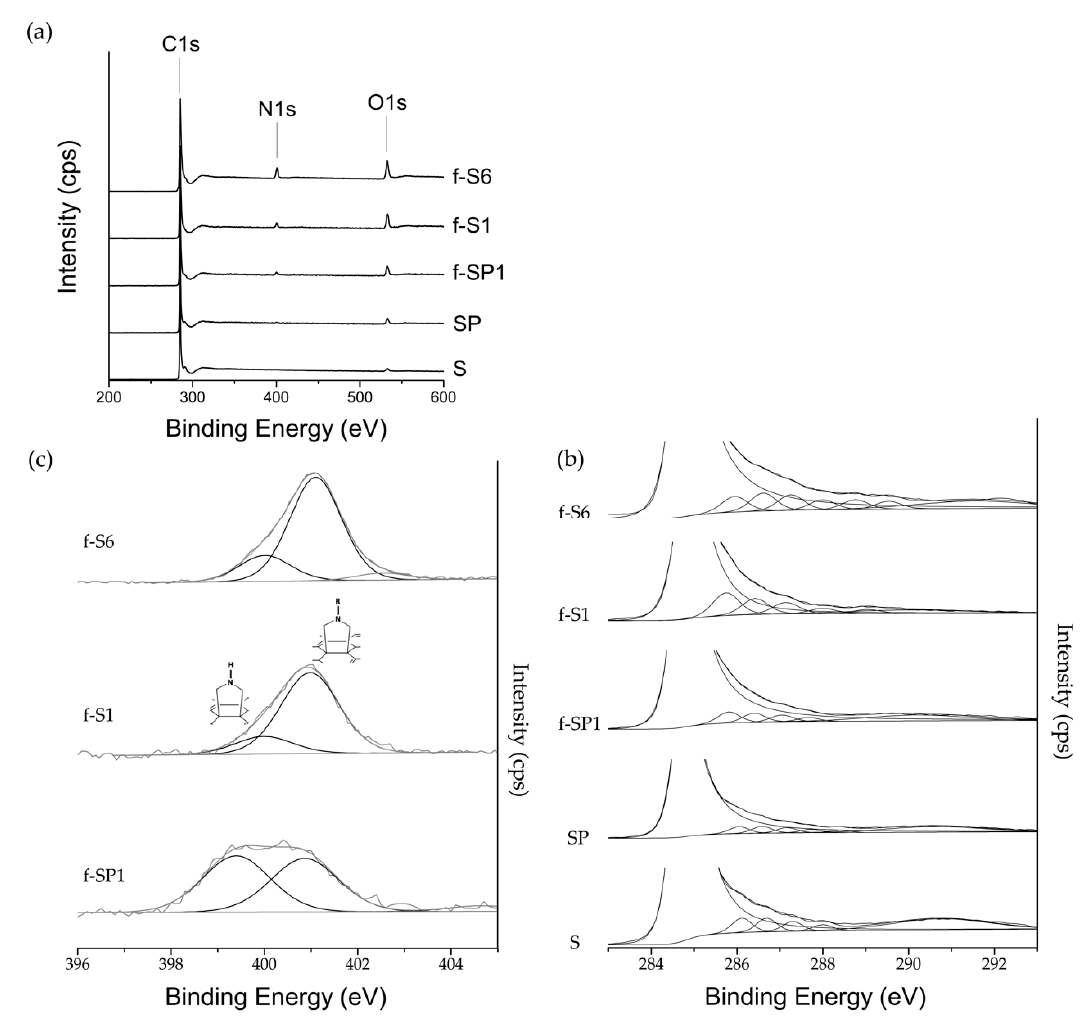
Figure 5. ( a ) Wide scan X-ray photoelectron spectroscopy (XPS) spectra of pristine, purified, and f-SWCNT; deconvolution of high resolution XPS spectra of ( b ) C 1s peak of f-SWCNT, purified, and pristine SWCNT; and ( c ) N 1s of f-SWCNT. Table 3. Fraction of N at% relative to C and O, and the ratio > NH: > NR (pyrrolidine group to benzyl carbamate group) as measured by